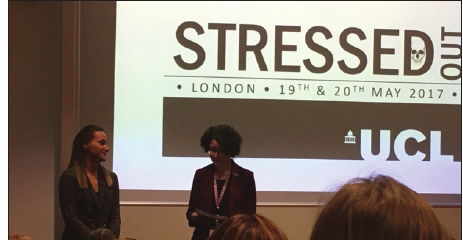
Figure 6: Dr Marija Edinborough (left) and Dr Carolyn Rando (right) during the closing comments at the Stressed Out conference. (Photo Kate